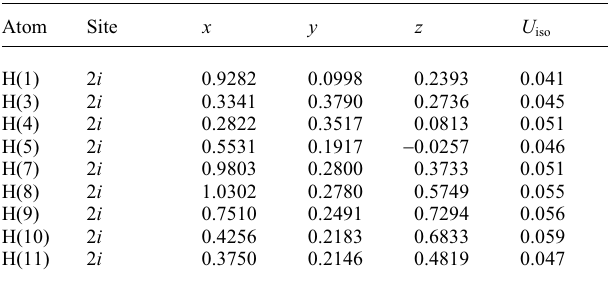
Table 2. Atomic coordinates and displacement parameters (in Å 2 )